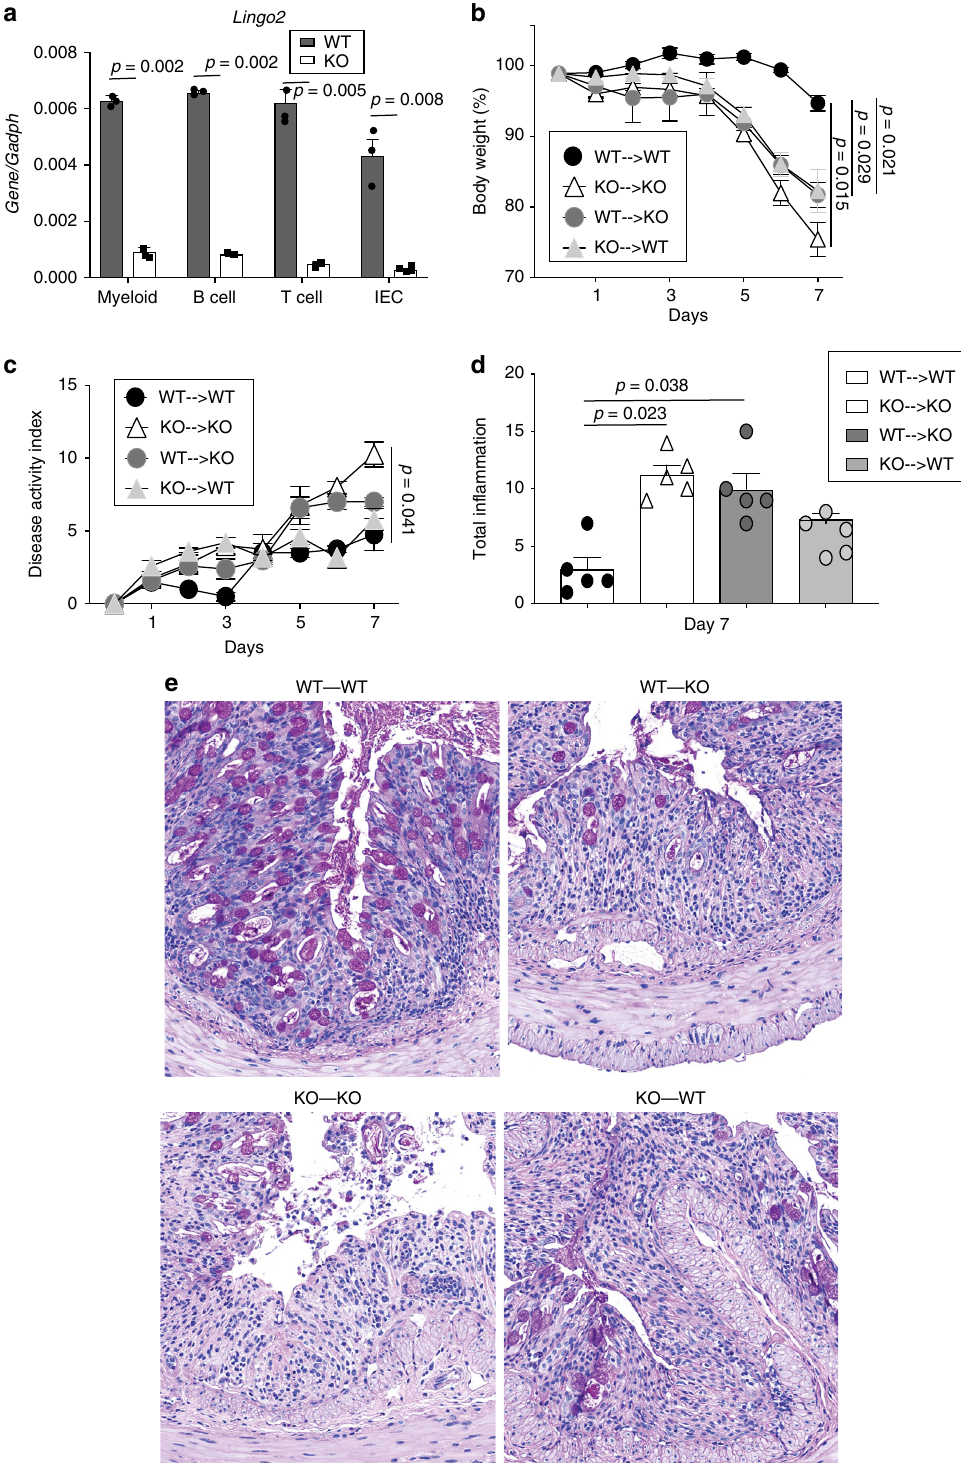
Fig. 4 Non-hematopoietic and hematopoietic cells contribute to LINGO2-mediated protection from DSS colitis. a RT-PCR quanti fi cation of Lingo2 mRNA transcript levels in myeloid, B cell, T cell and intestinal epithelial cells isolated using magnetic beads from WT and Lingo2 KO mice n = 3/group. Representative of two experiments with results of unpaired two tail t tests shown. b Change in initial body weight and c disease activity index and d clinical pathology in fl ammation score in colon tissues from irradiation bone marrow chimeras at 4 days following cessation of 2.5% DSS administration for donor- recipient combinations WT → WT, Lingo2 KO - → Lingo2 KO, WT → Lingo2 KO, Lingo2 KO - → WT. Mean± SE of 4 or 5 mice/group and results of two-way ANOVA analyses are shown. e Representative photomicrograph images at ×20 showing H&E stained colon tissues from irradiation bone marrow chimeras in ( b – d ). Scale 40 μ